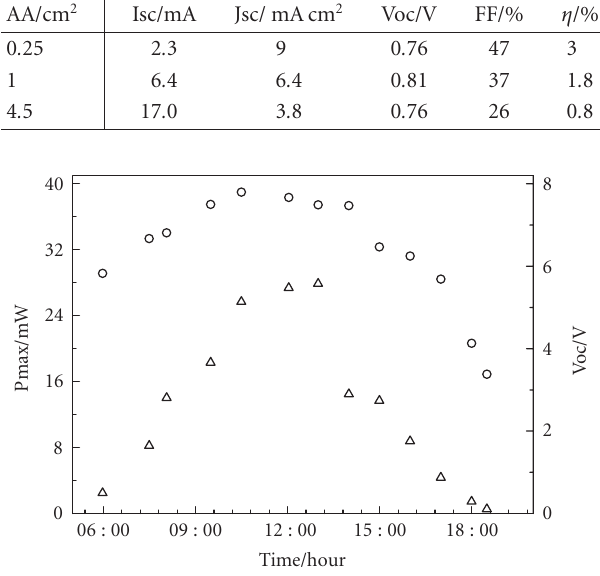
Figure 5: Variation of the maximum power (Pmax = Δ ) and open circuit potential (Voc = ◦ ) produced by the solar module assem- bled with 13 series-connected solar cells during one day of outdoor